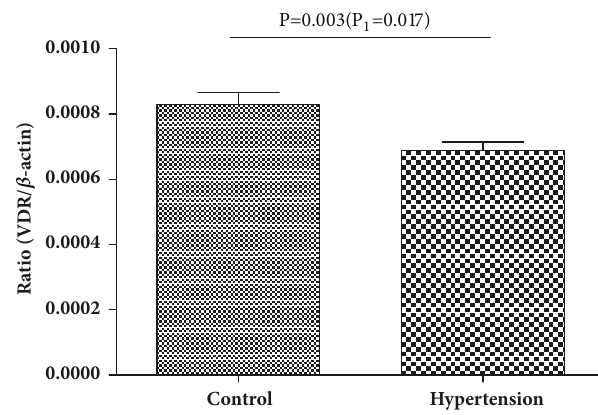
Figure 2: The level of VDR mRNA expression (Ratio (VDR/ 𝛽 - actin)) in hypertension and control group, VDR mRNA expression level was lower in children with hypertension than that in